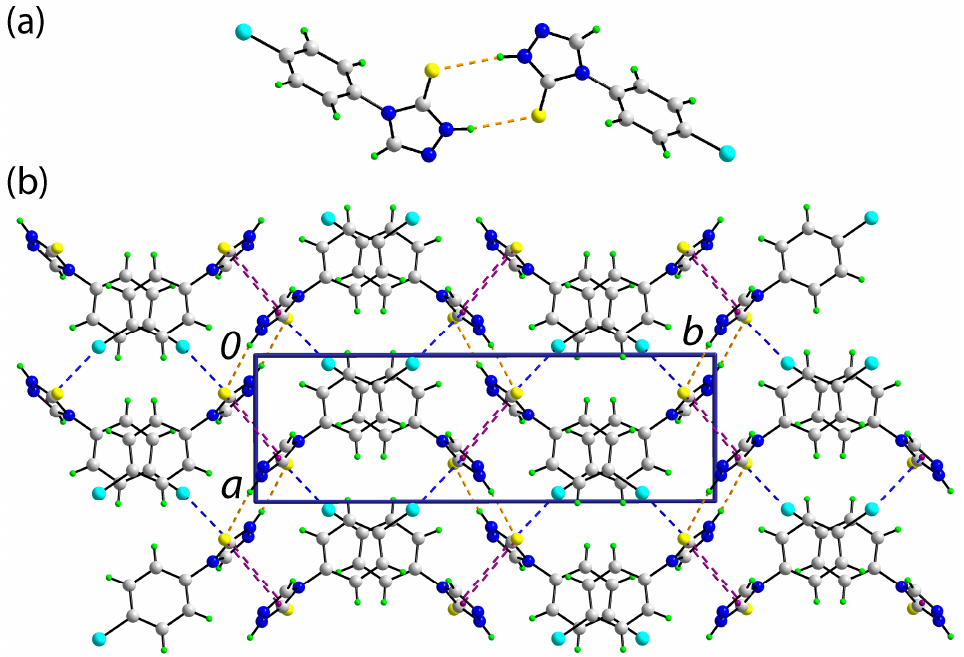
Figure 2. The molecular packing in the crystal of 1 : ( a ) a view of the supramolecular dimer sustained by thioamide-N-H · · · S(thione) hydrogen bonding [N3-H3n · · · S1 i : H3n · · · S1 i = 2.476(13) Å, N3 · · · S1 i 3.3335(12) Å with angle at H3n = 167.6(12) ◦ for symmetry operation i: 3/2 − x , − 1/2 + y , 1/2 − z ] shown as orange dashed lines and ( b ) a view of the unit cell contents shown in projection down the c -axis. The C=S · · · π (triazolyl) [C1=S1 · · · Cg(triazolyl) ii = 3.6888(6) Å and angle at S1 = 95.95(5) ◦ for symmetry operation ii: 1 − x , 1 − y , 1 − z ] and C-Cl · · · π (triazolyl) [C6-Cl1 · · · Cg(triazolyl) iii = 3.5321(7) Å and angle at Cl1 = 155.19(5) ◦ for symmetry operation iii: 1 + x , 3/2 − y , 1/2 + z .] interactions are shown as purple and blue dashed lines, respectively.